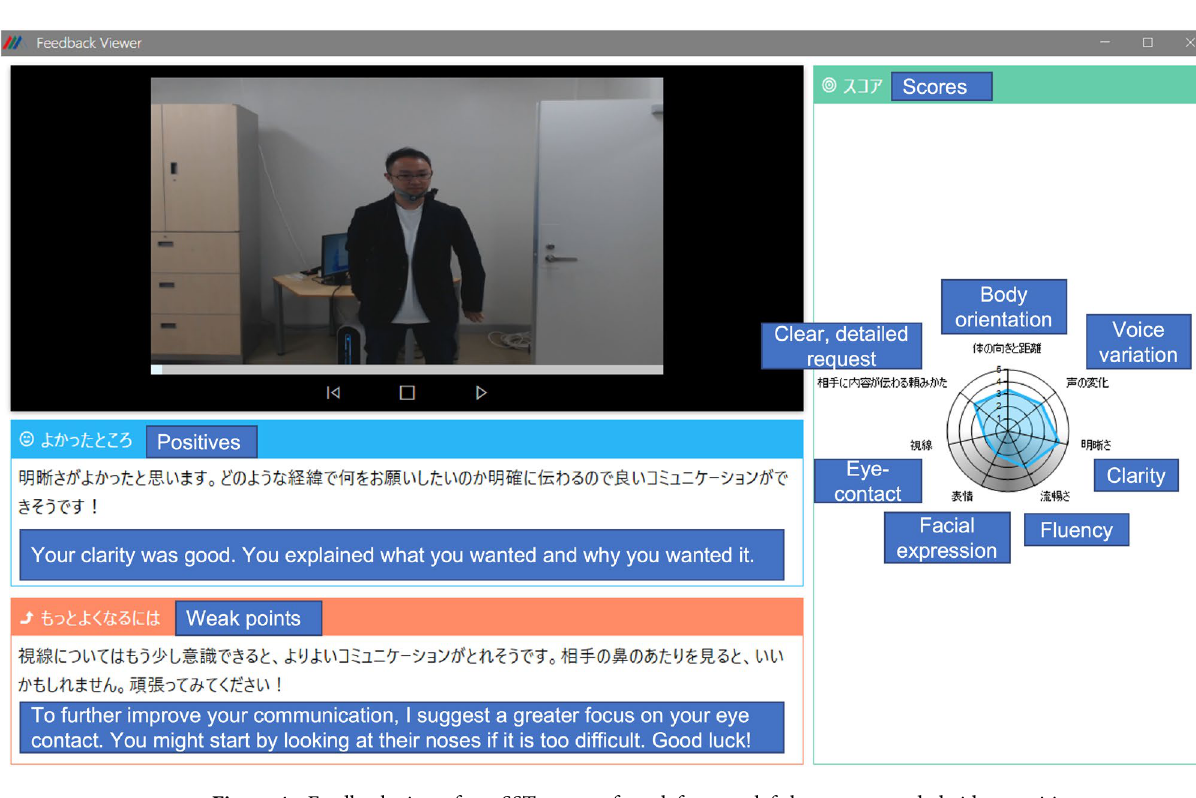
Figure 4. Feedback view of our SST system: from left-top to left-bottom: recorded video, positive comment, corrective comment, radar chart of predicted skill